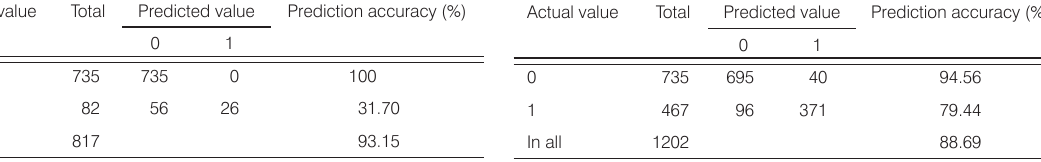
negative cases for which the prediction was correct in all cases; in contrast, the prediction was correct in only 26 out of 82 positive cases, with too many false-negative results.